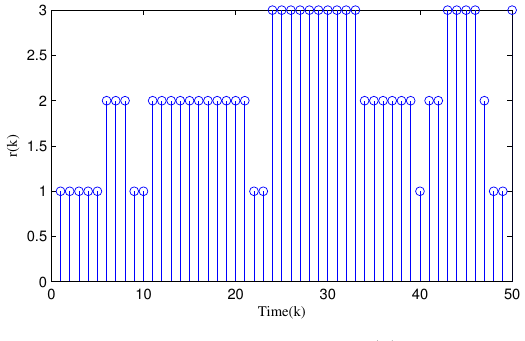
Figure 3. Evolution of r ( k )